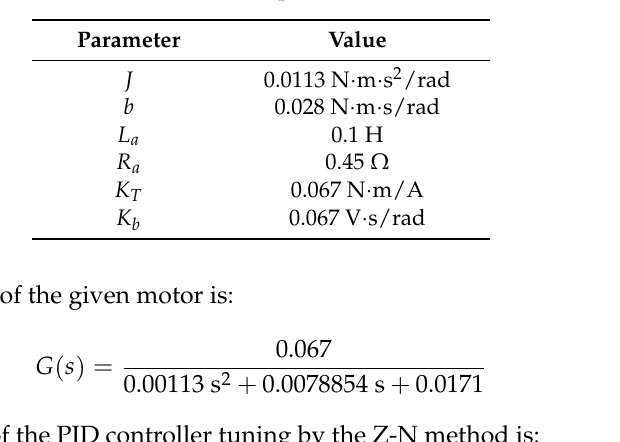
Table 1. Motor parameters.